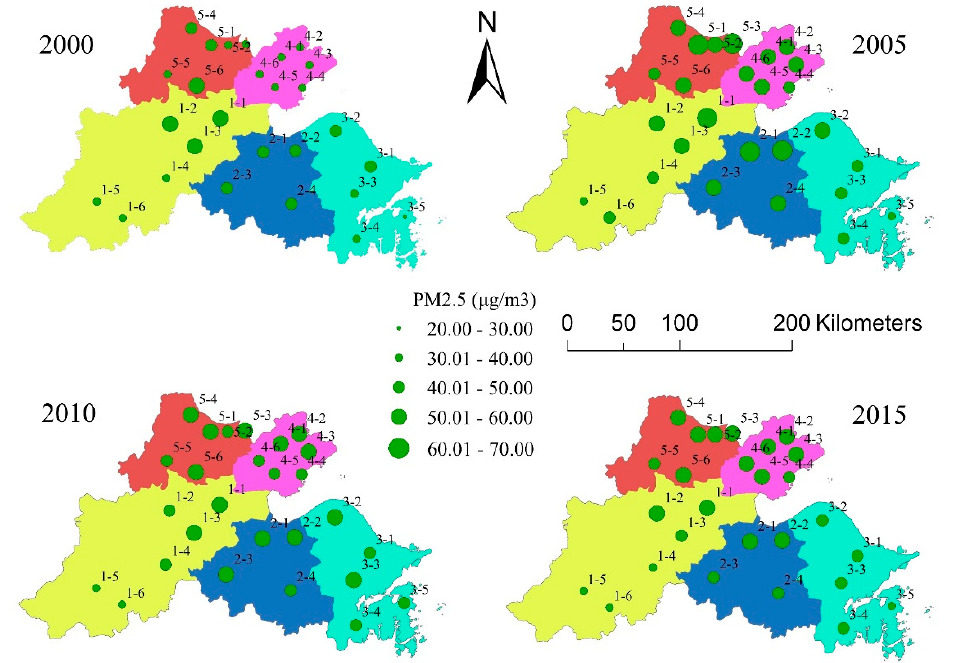
Figure 6. The annual mean fine particulate matter (PM 2.5 ) concentration in each urban